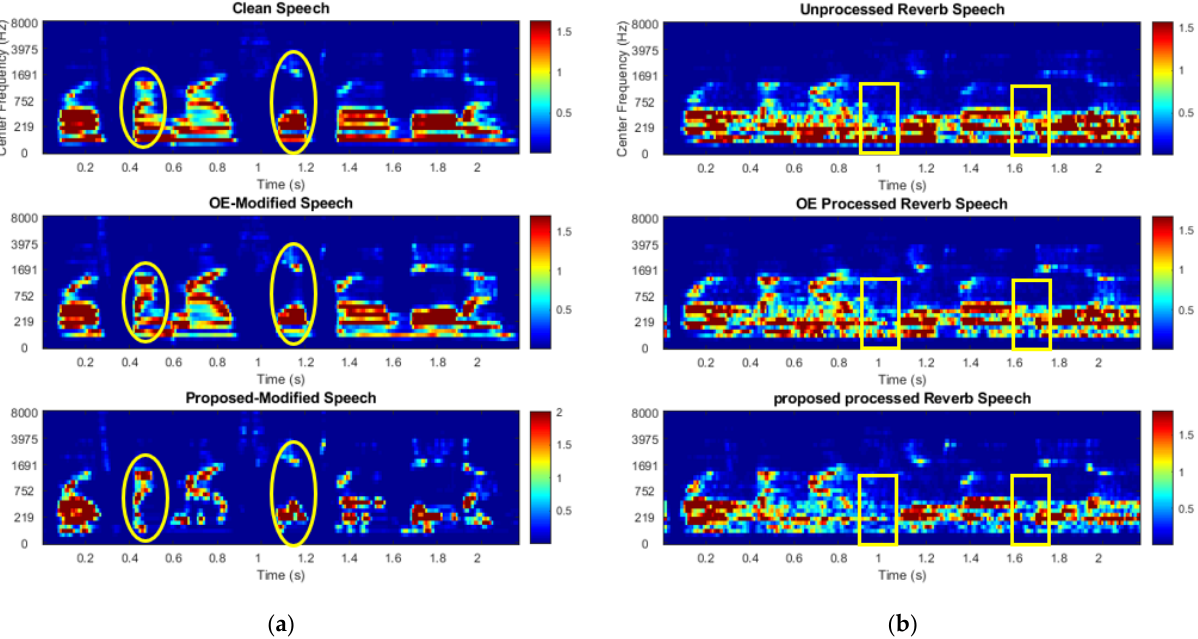
Figure 3. ( a ) The cochleagram of clean speech and two preprocessed speech signals are shown. The first-row panel shows the unprocessed speech sentence. Second-row panel shows a preprocessed speech sentence using OE algorithm and the third-row panel shows the preprocessed speech using the proposed algorithm obtained for room R4. The yellow ovals show the difference between the unprocessed signal and two enhanced signals. The preprocessing of OE and the proposed algorithm has a high-pass filter effect on the speech.; ( b ) The cochleagram of three reverbed signals in room R4 are shown. The first-row panel shows the unprocessed clean sentence. In the first-raw panel, a reverbed unprocessed speech sentence is depicted. The second-row and third-row panels show a reverbed preprocessed speech sentence using OE algorithm and the proposed algorithm respectively. Yellow rectangles show the effect of the frame attenuations in the OE and proposed approaches. In the third panel belonging to the proposed method, there is a low amount of energy leakage from previous frames into the silent gap in comparison to the unprocessed and OE-preprocessed reverbed signals.